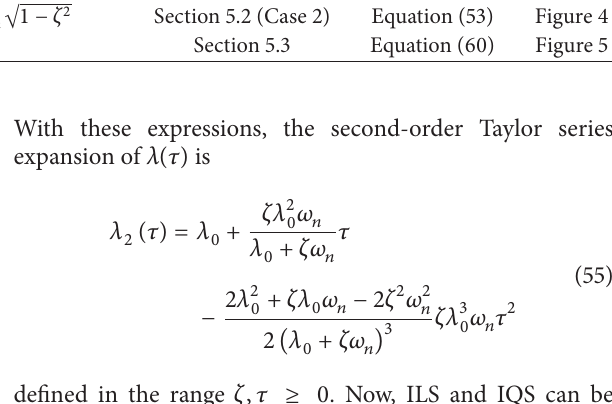
Table 1: Biot’s exponential model. Damping parameters, considered eigenvalue functions, and initial values of the proposed method. Parameter, 𝜃 Function 𝜆(𝜃) Section 𝐷(𝜆,𝜃) Results 𝜃 = 𝜇 Section 5.2 (Case 1) Equation (48) Figure 3 𝜃 = 𝜏 Section 5.2 (Case 2) Equation (53) Figure 4 𝜃 = 𝜁 Section 5.3 Equation